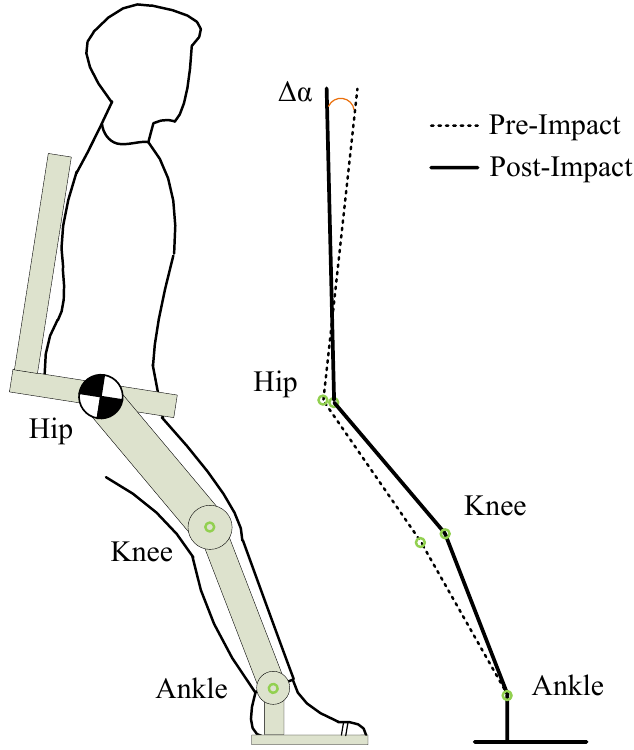
Figure 5. The knee flexion of the OKTM causes an axial rotation in the angle of the